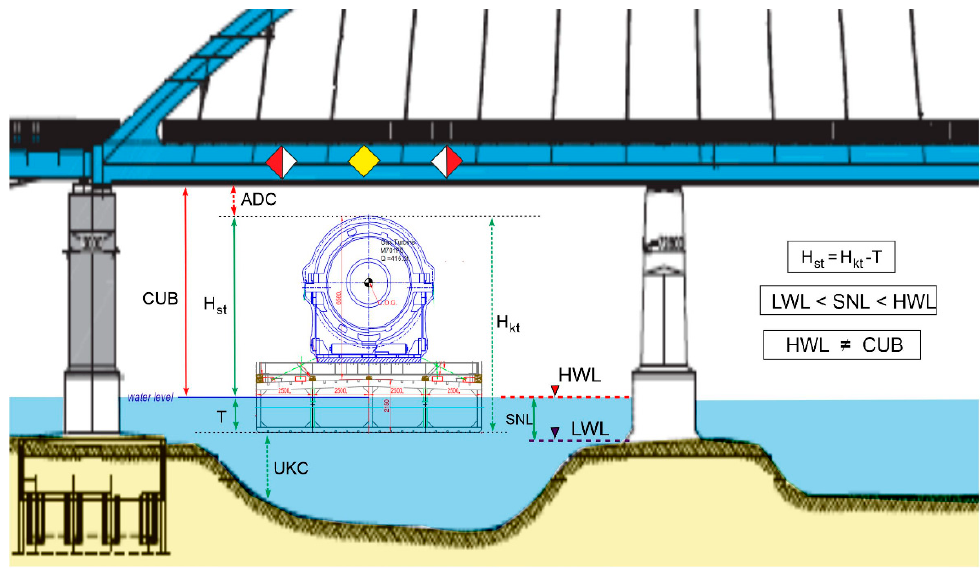
Figure 3. Scheme of the bridge cross-section on the waterway and steps in limitation of water level for safe navigation. Explanations: ADC—Air Draught Clearance; H kt —height of the ship from keel to the top of the cargo, H st —height from the water level; CUB—Clearance under the bridge, T—ship draught value (T = 1.2 m), UKC—under keel clearance value (UKC ≥ 0.1 m); HWL—high water level limit; LWL—low water level limit; SNL—safe navigation layer (see Figure